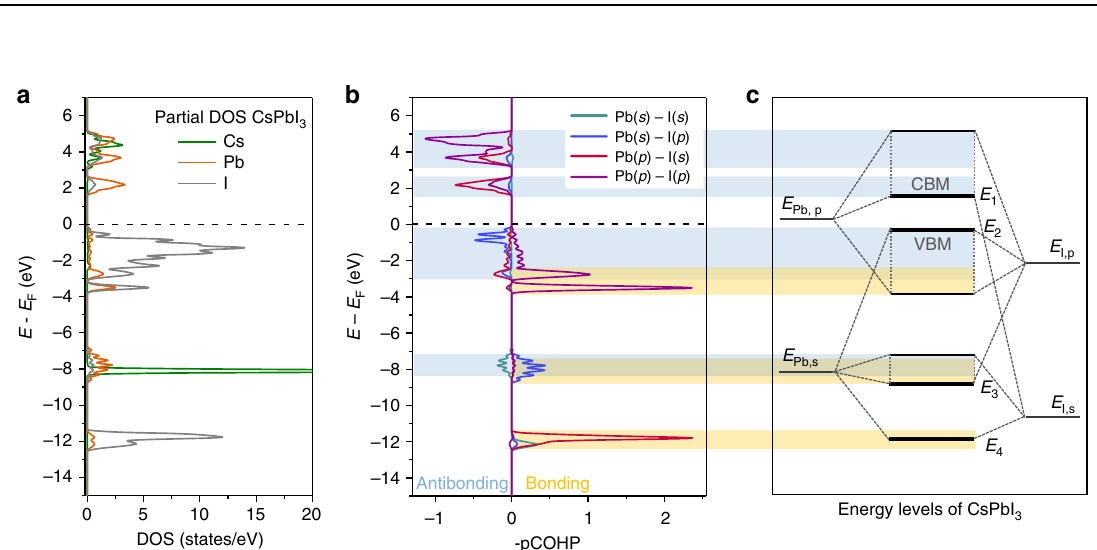
Fig. 3 Orbital contributions to the energy bands of CsPbI 3 . a CsPbI 3 DOS projected on the Cs, Pb, and I atoms (partial DOS). b Orbital-resolved COHP; positive (negative) sign indicates bonding (anti-bonding) character. The line colors indicates which atomic orbitals are involved in the bonds (anti-bonds). c Schematic energy level diagram extracted from the COHP analysis; the energy levels E 1 to E 4 which are relevant for the tight-binding analysis are marked. Bonding interactions are shaded in yellow, and anti-bonding interactions in